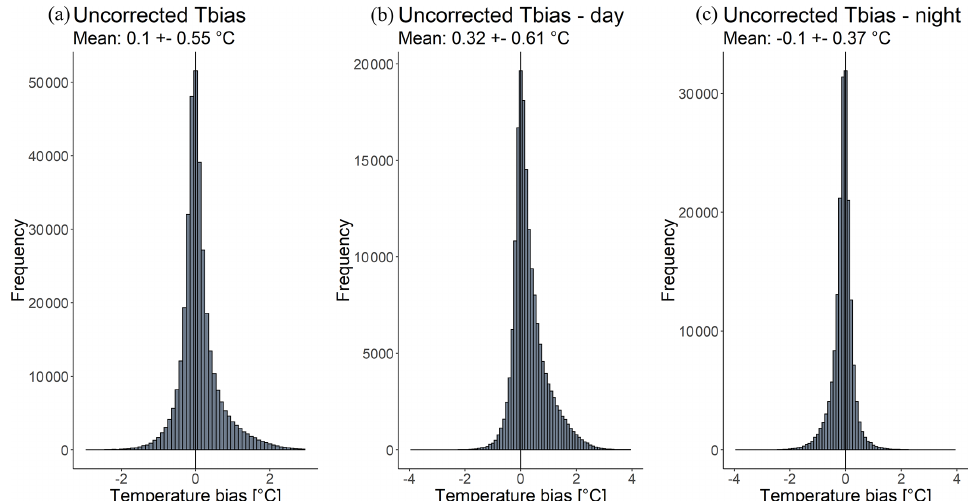
Figure 3. Histograms of the temperature bias between the low-cost reference stations (LC-R stations) and the official RMI stations (AWSs) for day and night (a) , with daytime defined by radiation > 0Wm − 2 (b) and night-time defined by radiation = 0Wm − 2 (c) . Mean biases and their standard deviations are given above the graphs. Note that the ranges on the y axis differ for the different subplots. The temperature bias was calculated for all measurements between the installation date of each LC-R and December 2021.